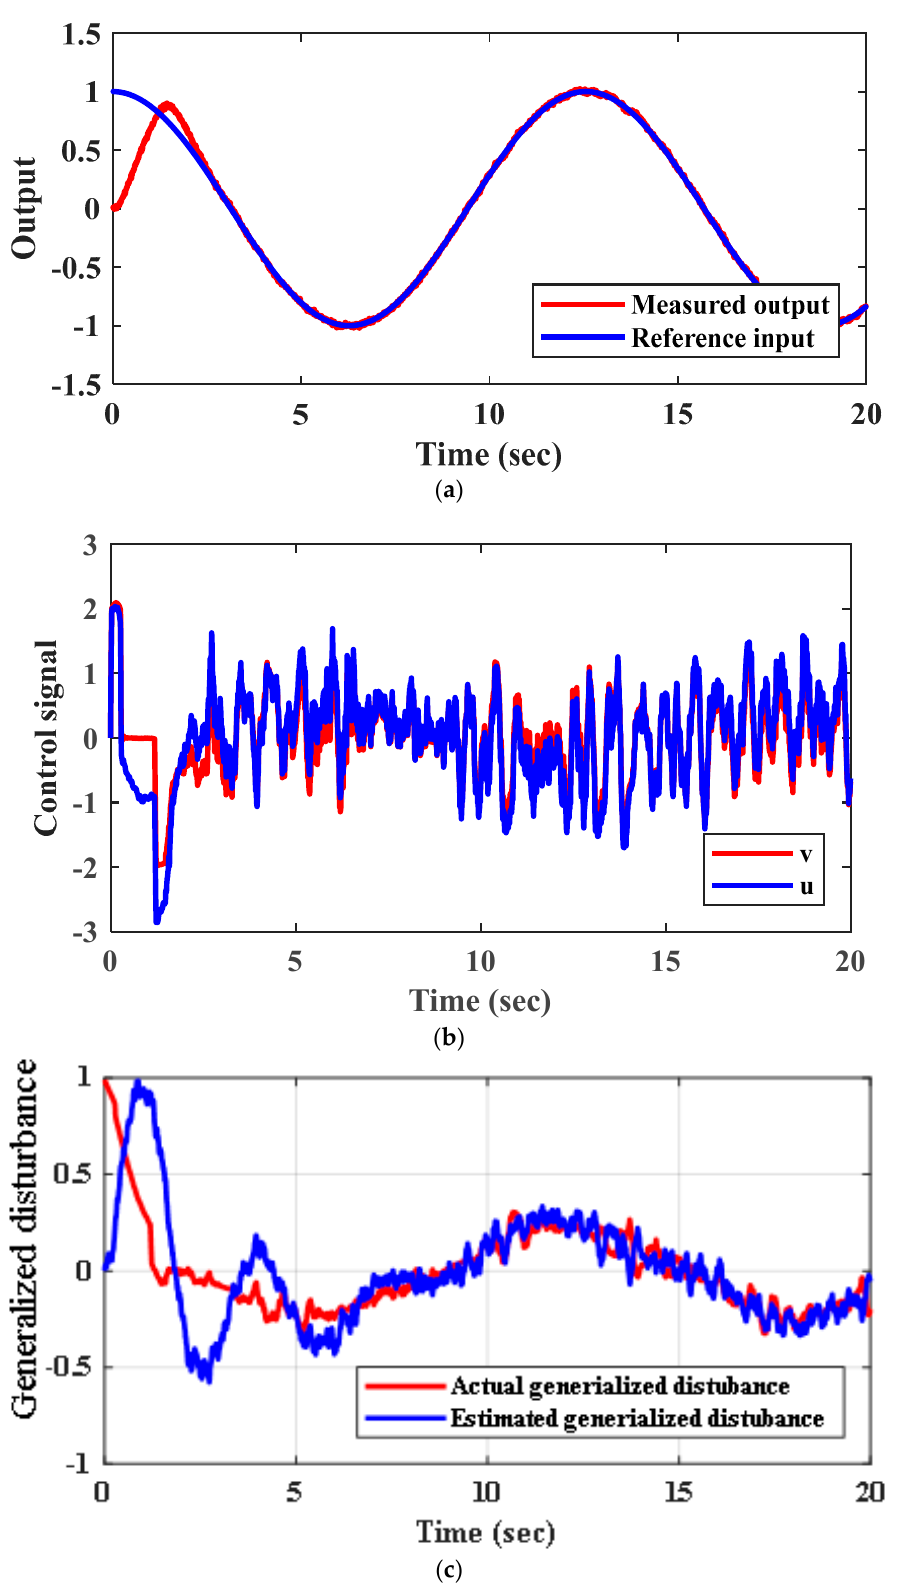
Figure 5. Numerical simulation results for Scenario 3: ( a ) tracking response y of the reference input r ; ( b ) control action u ; ( c ) estimation of the generalized disturbance ˆ ξ 3 .